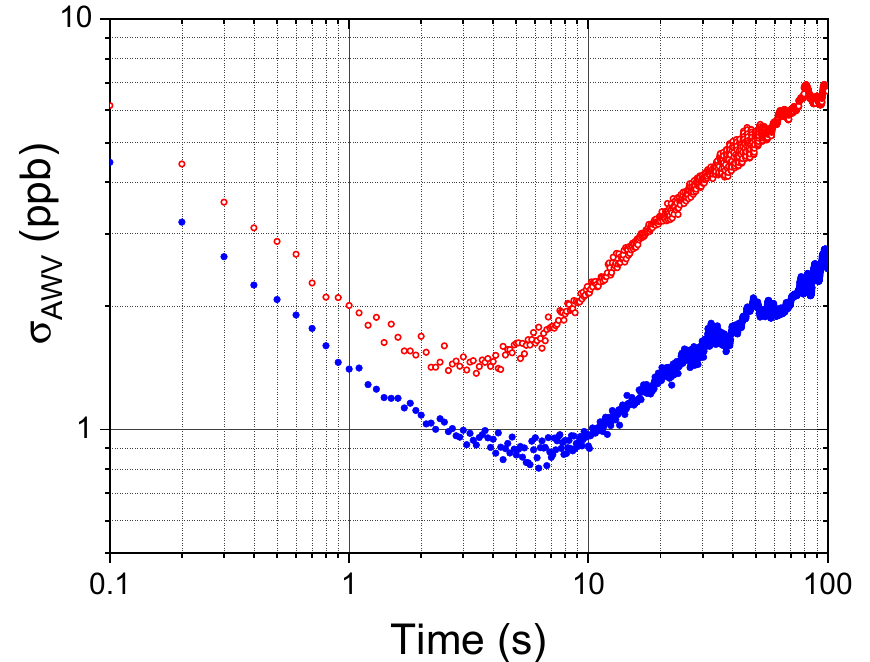
Figure 8. Allan-Werle Variance ( σ AVW ) plot of the CO mixing ratio as a function of the integration time, for 30 min measurement of a CO mixture (mixing ratio 125 ppbV) at a rate of 10 Hz, at a temperature of 295 K and for two different pressures: 980 mbar (red open circles) and 50 mbar (blue closed